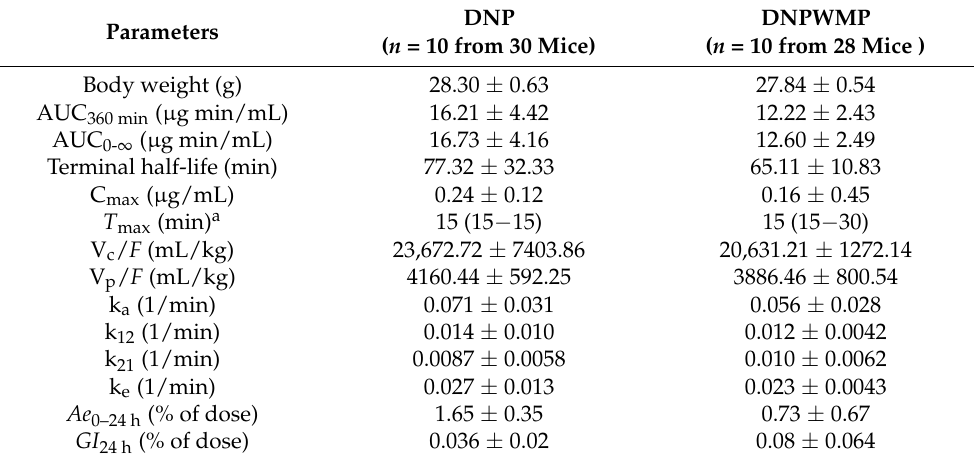
Table 1. Mean ( ± S.D.) pharmacokinetic parameters of donepezil after simultaneously oral adminis- tration of DNP (as 10 mg/kg of donepezil; n = 10 from 30 mice) without and with WMP (300 mg/kg; n = 10 from 28 mice) to mice, respectively.